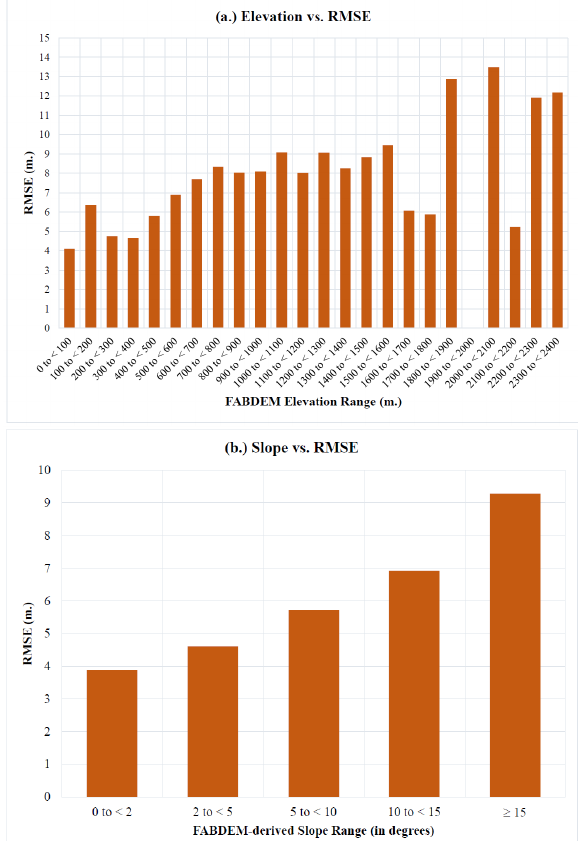
Figure 9. FABDEM RMSEs computed using all the GCPs located at different elevation ranges and slope